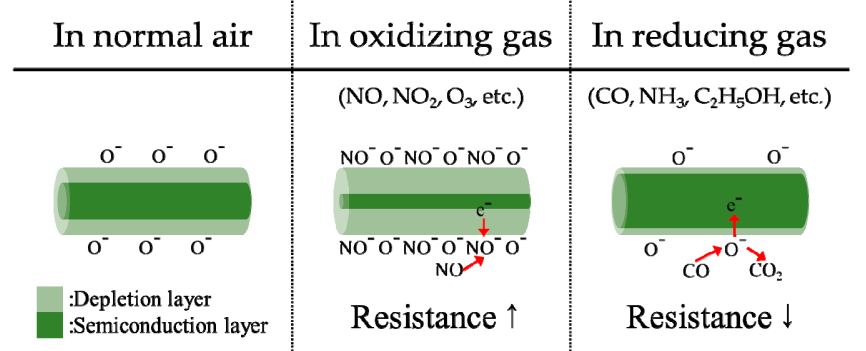
Figure 12. Operating principle of an MOS chemical sensor. N-type metal oxide semiconductors contains oxygen vacancies due to non-stoichiometry. When the sensor is exposed to oxidizing molecules at temperature between 200 and 400 °C, oxygen ions attach on the surface of the oxide, depriving electrons from the conduction band of the material. For this reason, the resistance of the sensing element increases. On the contrary, in presence of reducing molecules, the process is reversed and a decrease of resistivity is observed. Adapted from